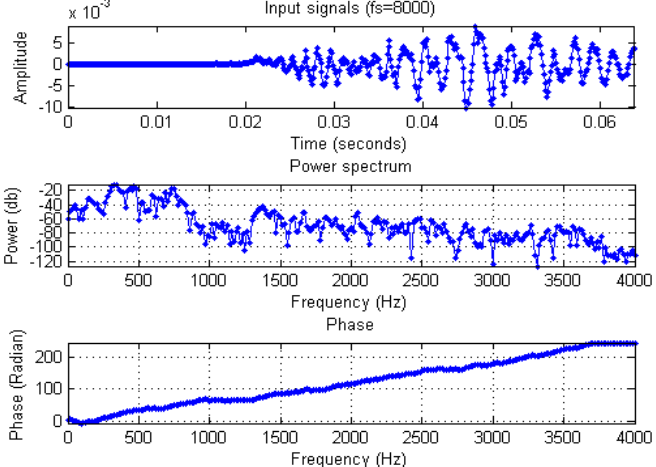
Figure 14. Frequency domain energy distribution of FFT.